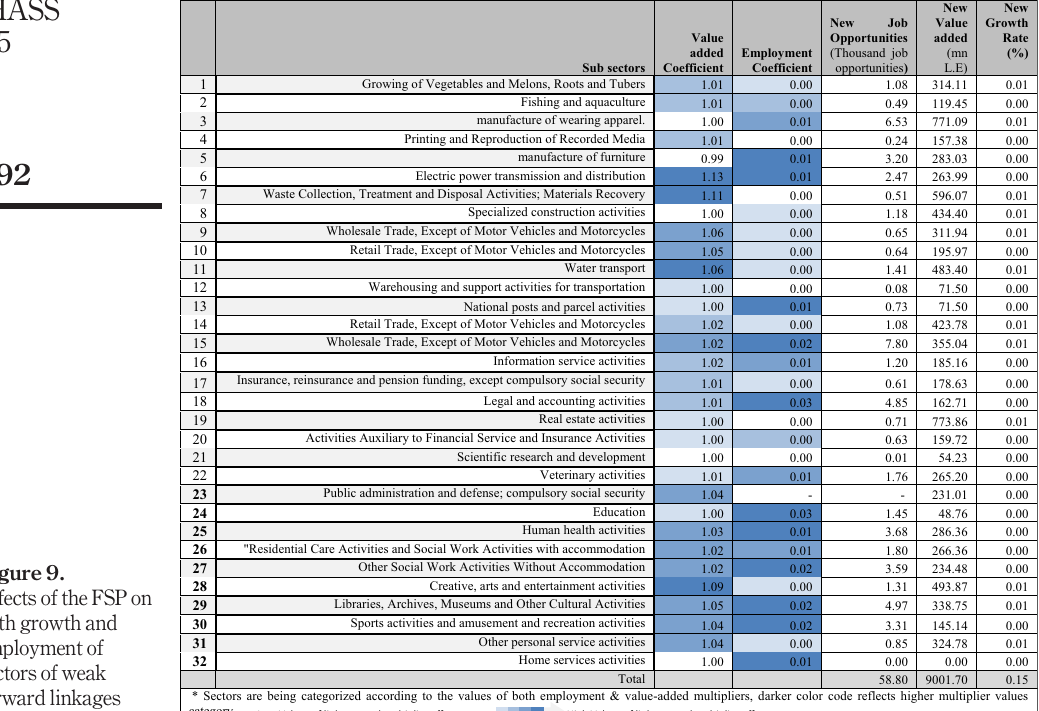
Figure 9. Effects of the FSP on both growth and employment of sectors of weak forward